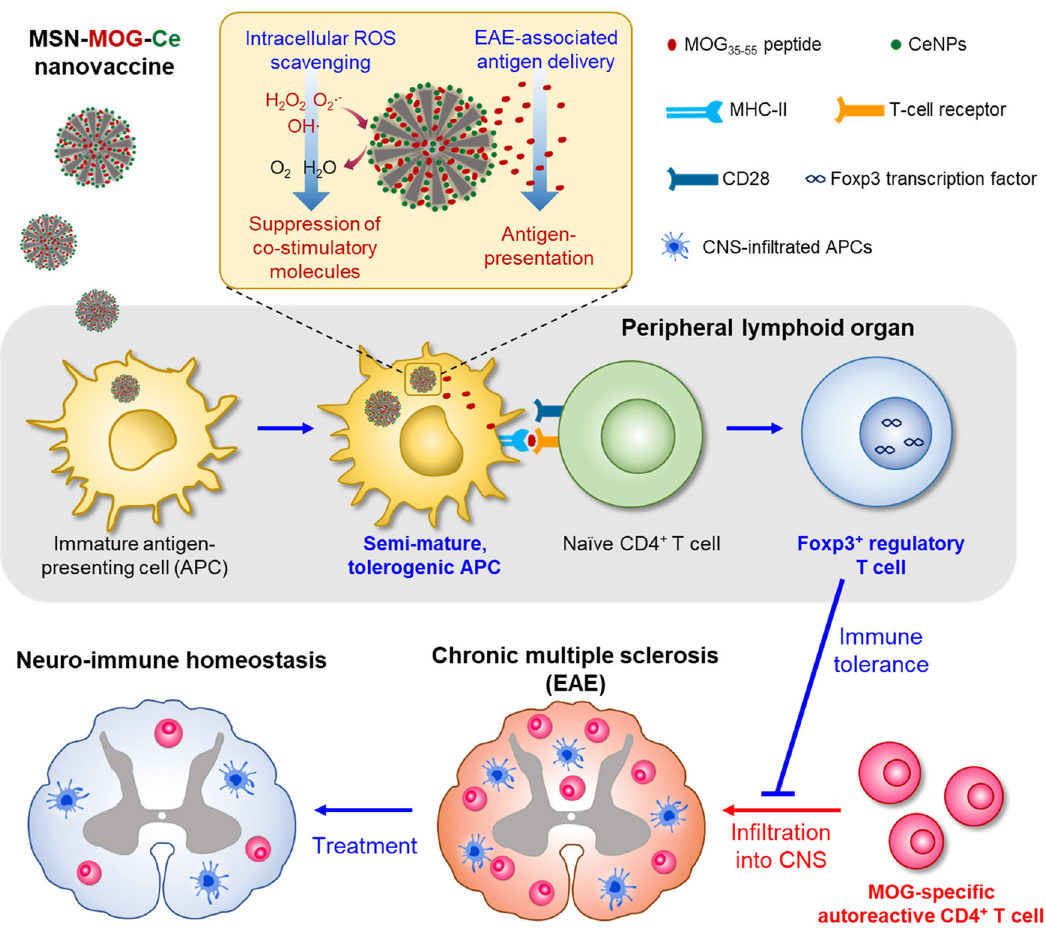
Fig. 7 | Proposed schematics of the immunosuppressive therapeutic nano- particle vaccine to treat EAE via re-establishing antigen-speci fi c immune tol- erance. The accumulation of CeNPs-decorated, MOG-loaded MSNs in the APCs resulted in the reduction of intracellular ROS and expression of costimulatory molecules (CD86, CD40) on APCs, leading to the suppression of APCs activation, thus making APCs more tolerogenic. The interaction between the MOG peptide presented by MHC-II on semi-mature, tolerogenic APCs and T-cell receptor on